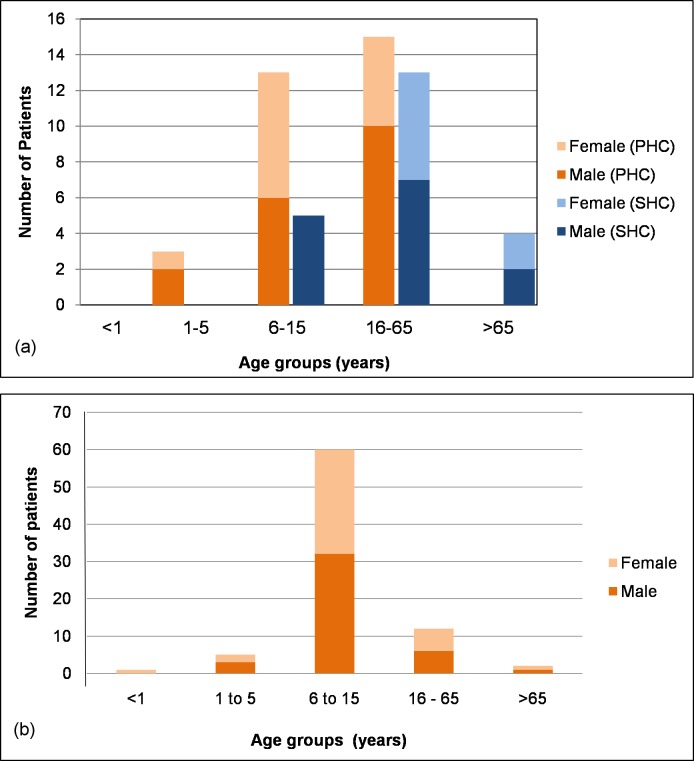
Age and sex distribution of patients with IS2404 PCR positive ulcers at the PHC and the SHC centers (a) and patients with PCR negative ulcers at the PHC center (b).